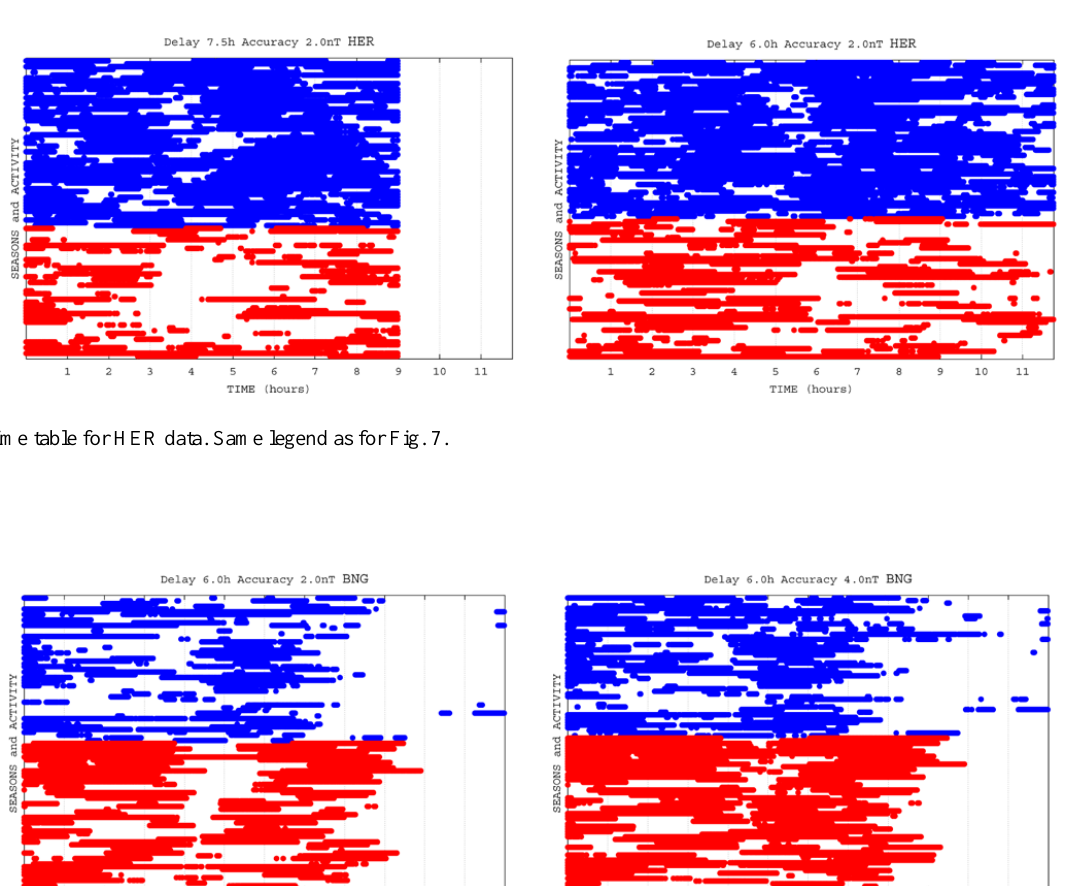
Geosci. Instrum. Method. Data Syst., 2, 1–9, 2013